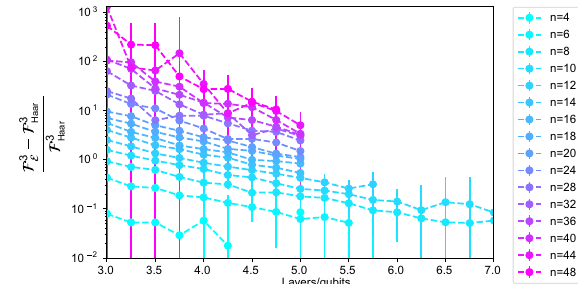
Fig. 6 Fractional deviation of the k = 3 frame potential from the Haar value as a function of layers over the number of qubits for the local random unitary ansätz. Error bars show one standard error.